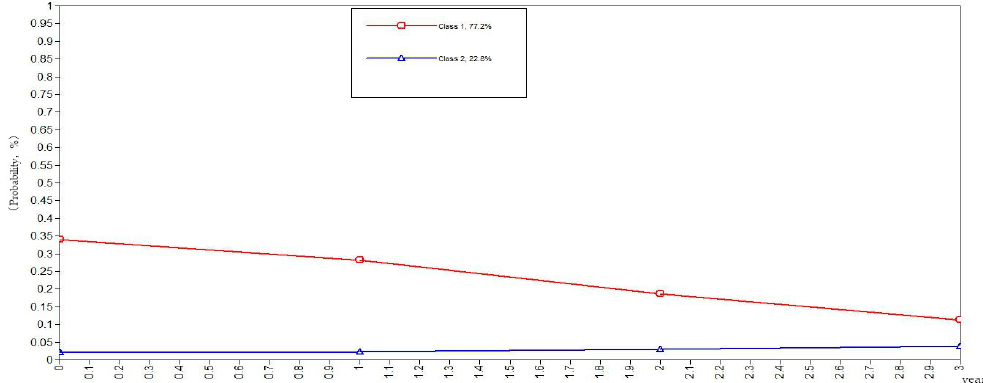
Figure 1. Evolution trends of the elderly with negative health behaviors.